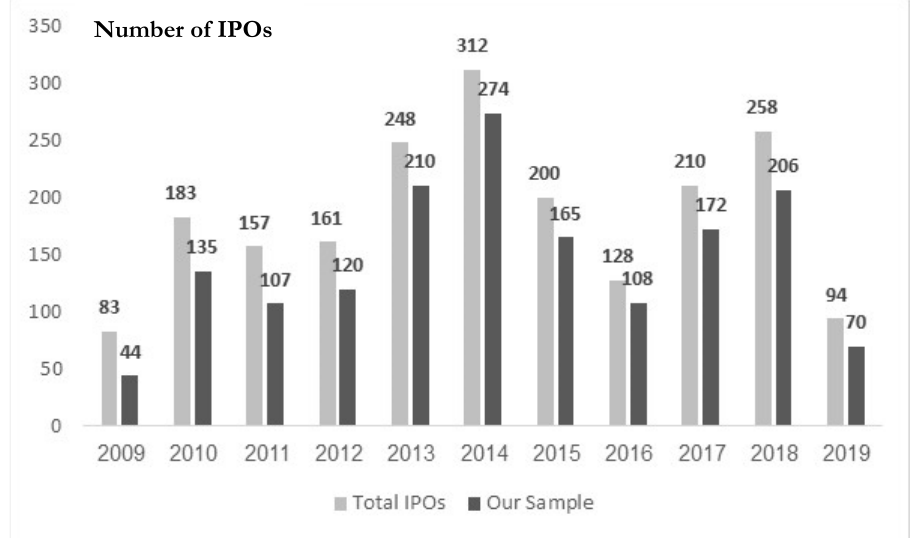
Figure 1. The evolution of IPOs in the US: April 2009 to May 2019.